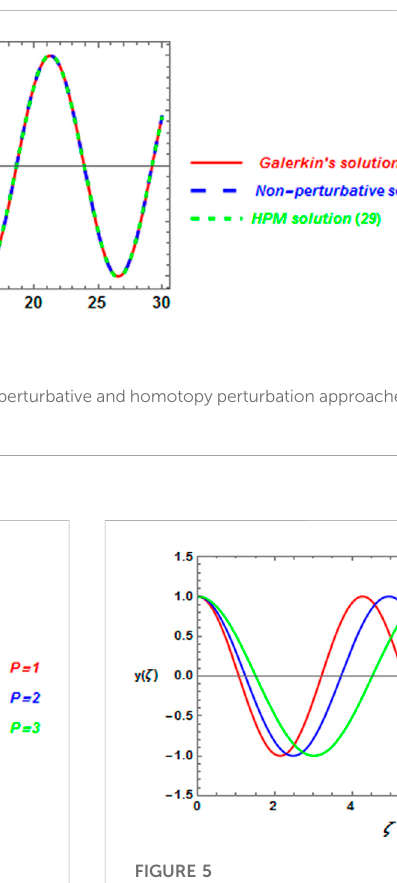
FIGURE 3 In fl uence of the parameter P on the periodic solution Eq. 32.